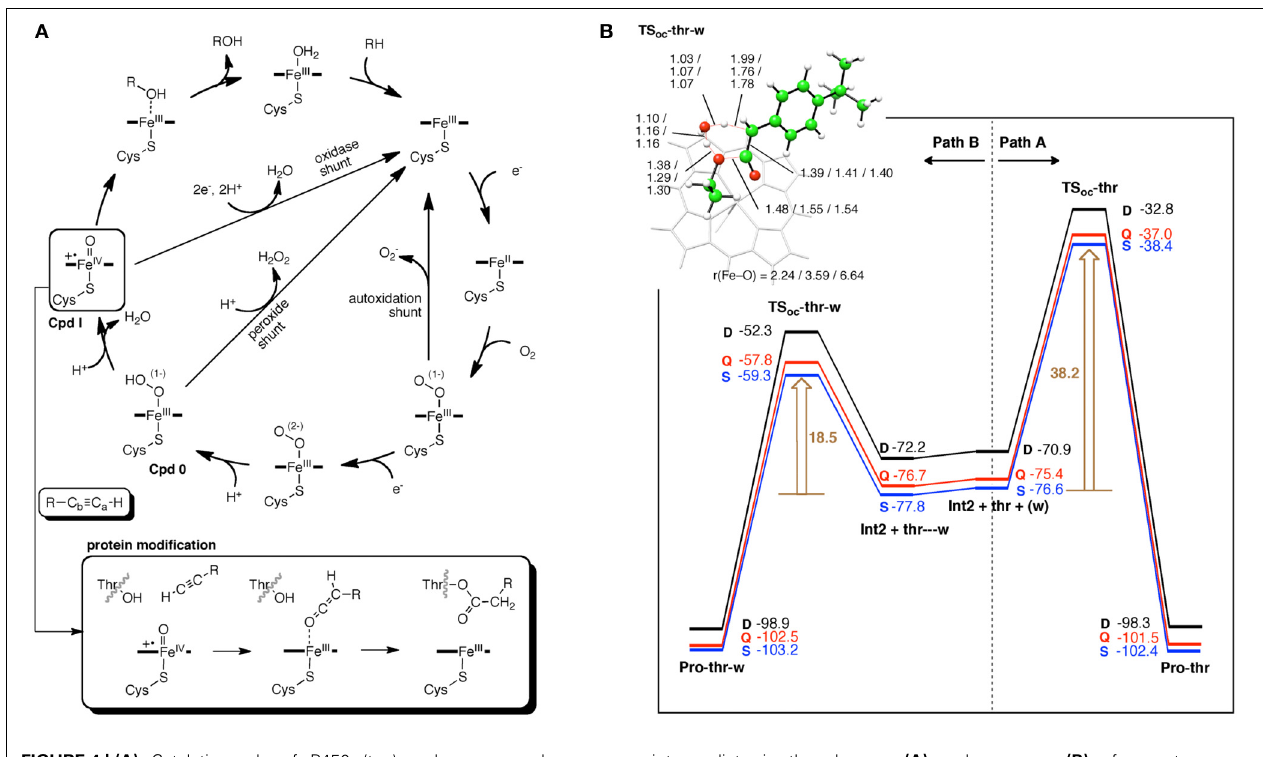
FIGURE 4 | (A) Catalytic cycle of P450 (top) and a proposed mechanism of MBI caused by terminal acetylenes (bottom) (B) Energy diagrams (in kcal/mol) for the reactions of a ketene